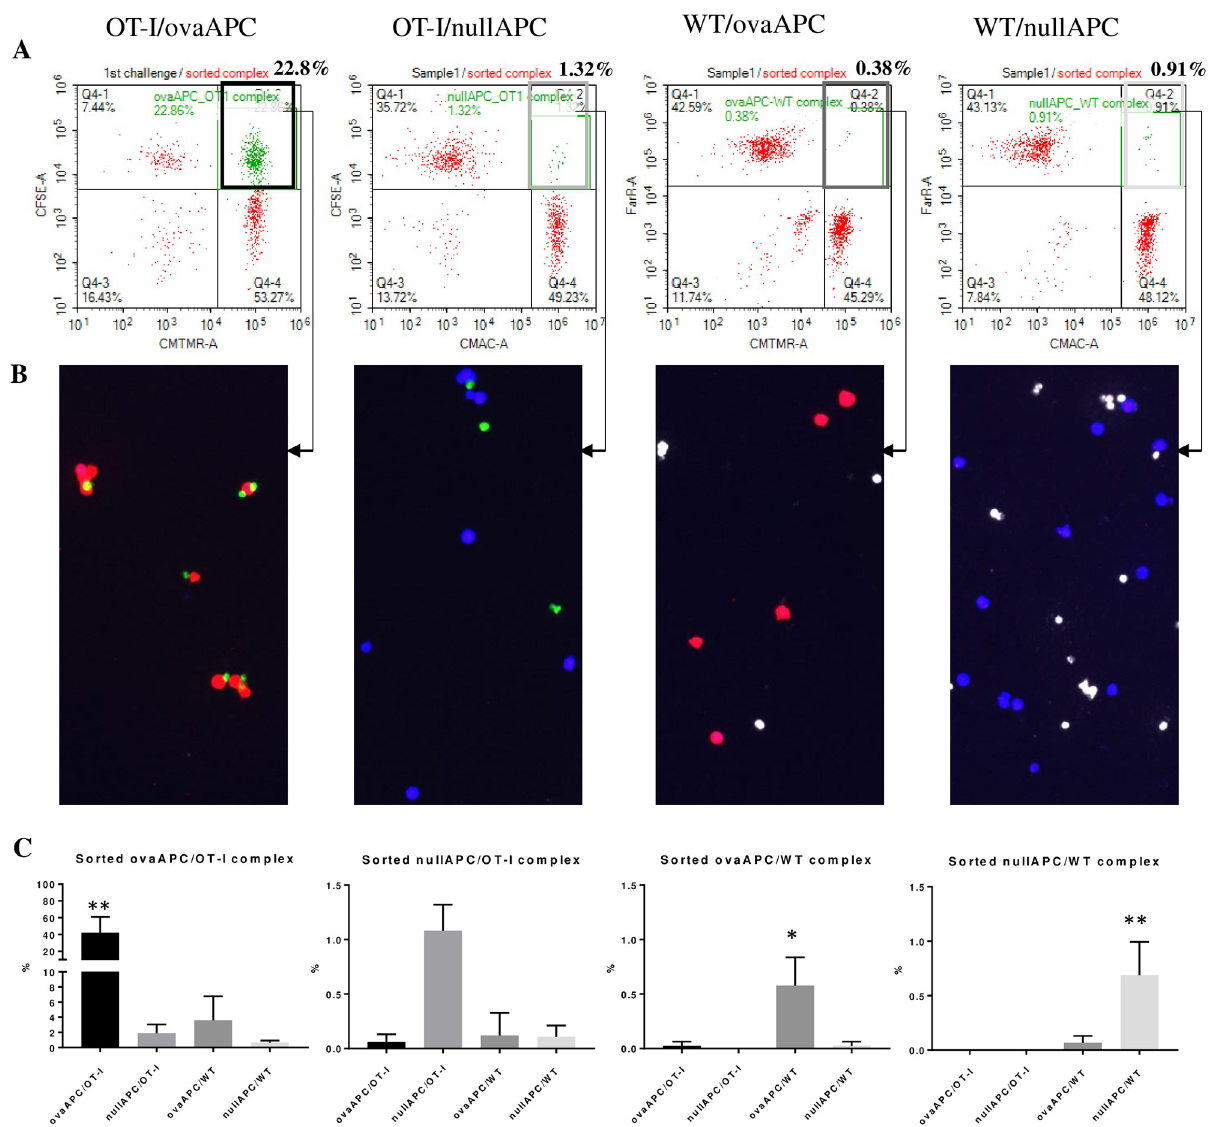
Fig 4. Non-specific cellular complex sorting using a microfluidics sorter. (A) The specific (OT-I/ovaAPC) and non-specific (OT-I/nullAPC, WT/ ovaAPC, and WT/nullAPC) cellular complexes were sorted, following which the sorted complexes were re-analyzed for the enrichment of the sorted population using On-chip Sort. A representative plot of three independent experiments with similar results. Upper right area of each plot shows the percentage of intact T/APC complexes of the sorting target population. Representative data of at least three independent experiments with similar results has been shown. (B) Fluorescent micrographs of the sorted cellular complexes. (C) Each sorted complex contained a small amount of non- targeted populations. The sorted complexes were re-analyzed to check the concomitant existence of non-targeted complexes. Sorted OT-I/ovaAPC also contained a small amount of the other cellular complexes including OT-I/nullAPC, WT/ovaAPC, and WT/nullAPC. Similarly, the OT-I/nullAPC, WT/ ovaAPC, and WT/nullAPC sorted populations also contained the other cellular complexes. The bar graph indicates mean ± SD of three independent experiments. �� p < 0.005, � p < 0.05 using ANOVA (with Kruskal-Wallis